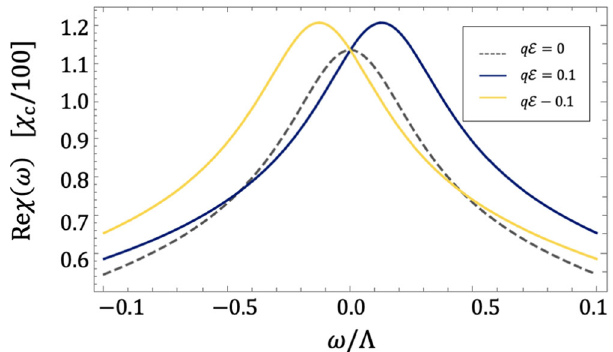
Fig. 4 Dynamical susceptibility away from charge neutrality. Real part of the dynamic pairing susceptibility χ ( ω ) for different values of boundary electric fi elds E corresponding to different carrier density with γ = 0.01, ν = 10 − 3 , and T / Λ = 10 − 2 . Notice spectral asymmetry away from n =